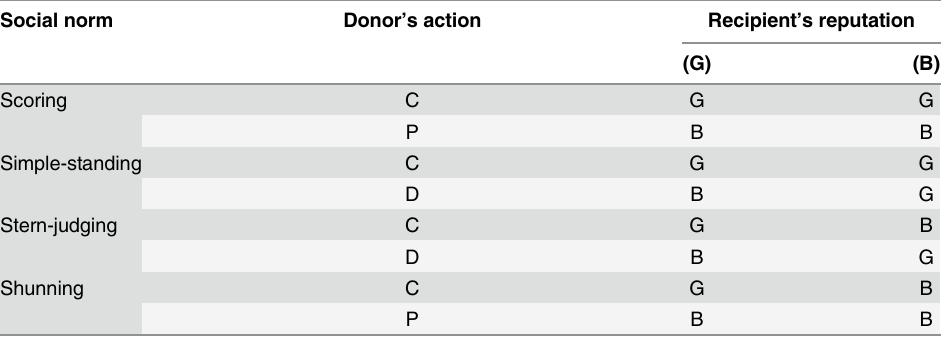
Table 1. Social Norms. Definition of the second order social norms investigated in the model (after Ohtsuki et al. [2]). Second order social norms specify the donor ’ s reputation as a function of the donor ’ s action and the recipient ’ s reputation. Where C, D and P denote cooperate, defect and punish respectively; while G and B denote good and bad. Social norm